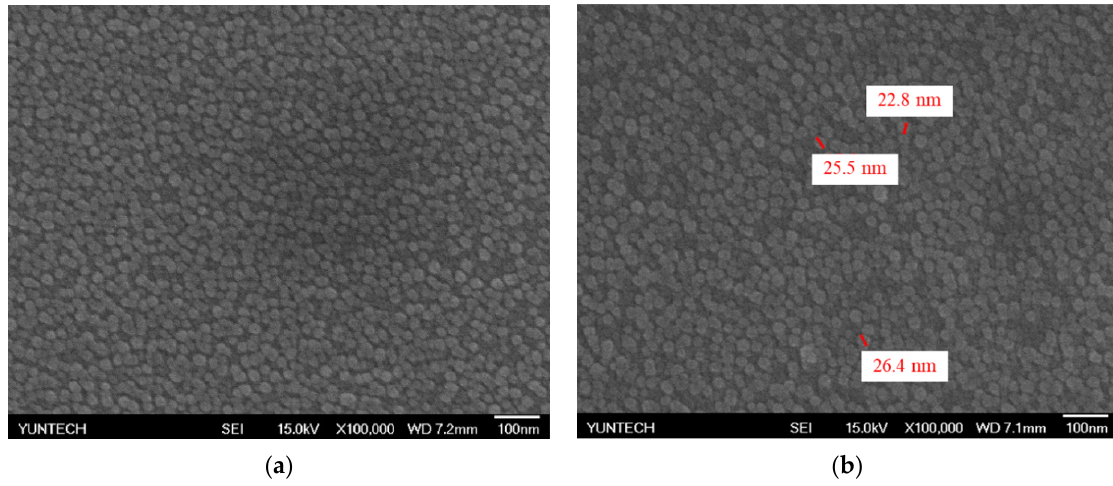
Figure 5. The FE-SEM images of ( a ) the surface morphology of copper-doped zinc oxide ( CZO ) film and ( b ) the particle size of CZO film. Table 1. The element contents of copper-doped zinc oxide (CZO) film.